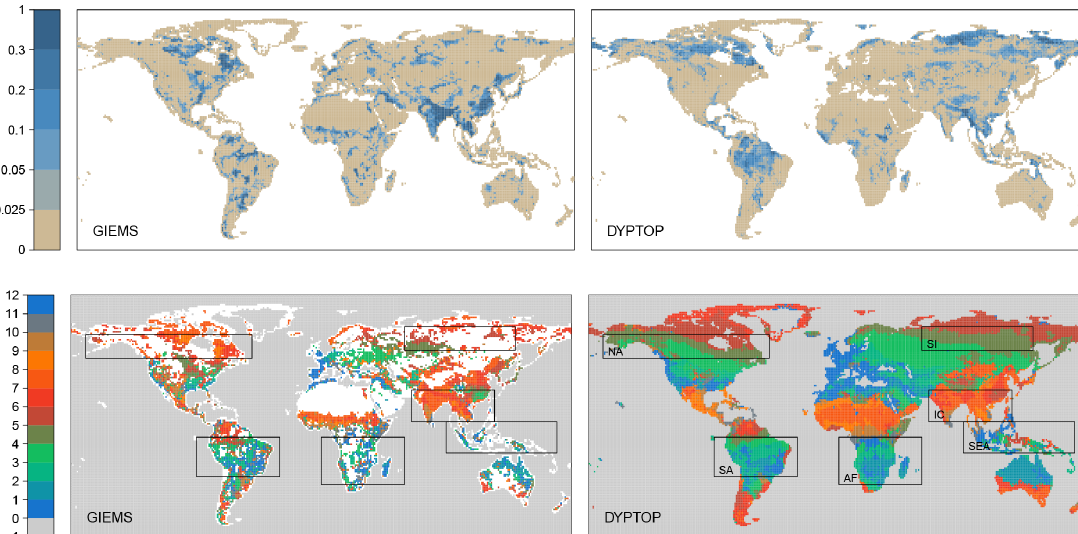
Figure 5. Top row: estimated (left, Prigent et al., 2007) and simulated (right) annual maximum inundated area fraction, averaged over 1993 to 2004. The fraction of simulated established peatlands (see Fig. 7) is subtracted from the simulated inundation area fraction for a better comparison with GIEMS. The data shown here thus correspond to f inund (Eq. 16). Note the non-linear scale. Bottom row: estimated (left) and simulated (right) month with maximum inundation extent. Months are numbered from 1 (January) to 12 (December). Boxes define regions for which mean seasonality is analysed in Fig. 6. Blank land grid cells in the map at the bottom-left represent locations where the inundation area is zero throughout the